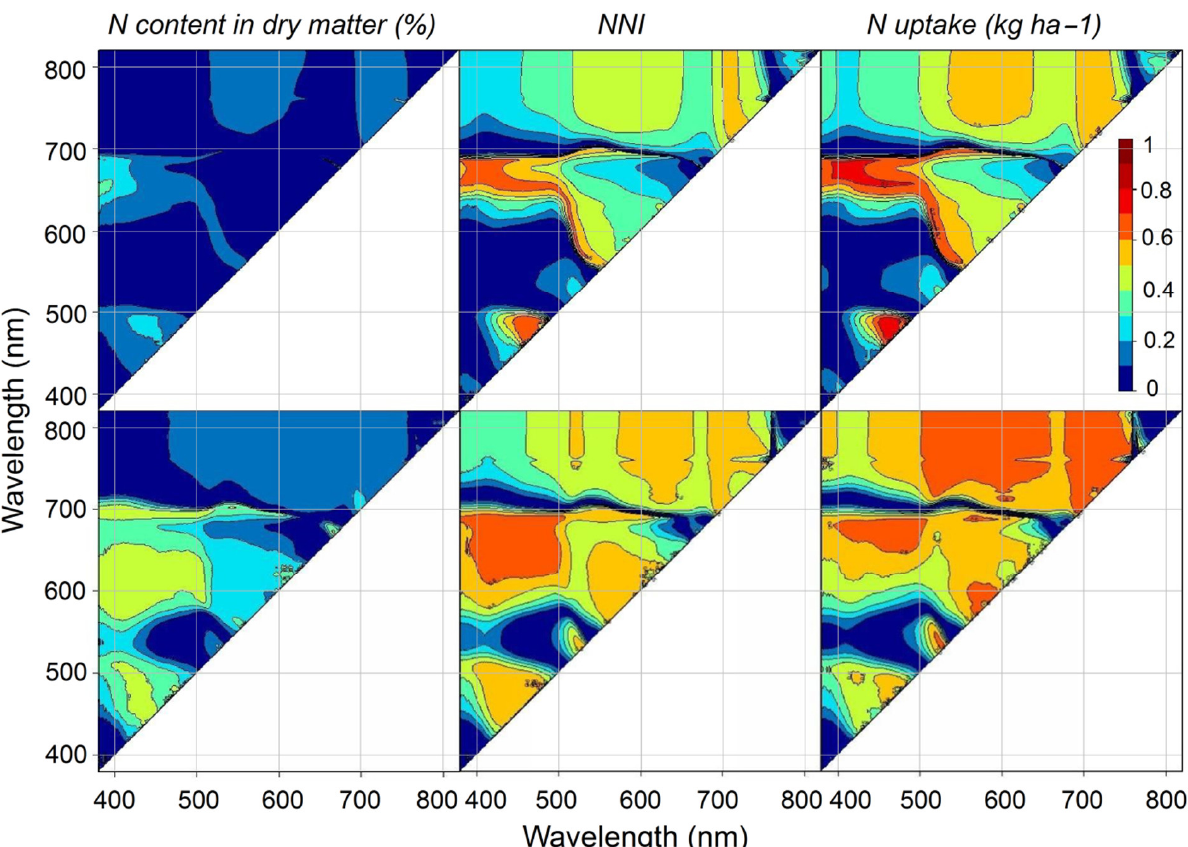
Figure 1. Matrix plots of coefficients of determination ( R 2 ) for the relation of all combinations of wavelengths in the range 380–820 nm used for a linear regression analysis of the normalized difference index NDI xy = (R x − R y )/(R x + R y ), wherein R x and R y represent reflectance in wavelengths x and y, against N content in dry matter ( left ), nitrogen nutrition index (NNI, middle ), and N uptake by aboveground biomass ( right ). The correlations were calculated separately at stage DC 29–31 ( upper ) and DC 39 ( bottom ).